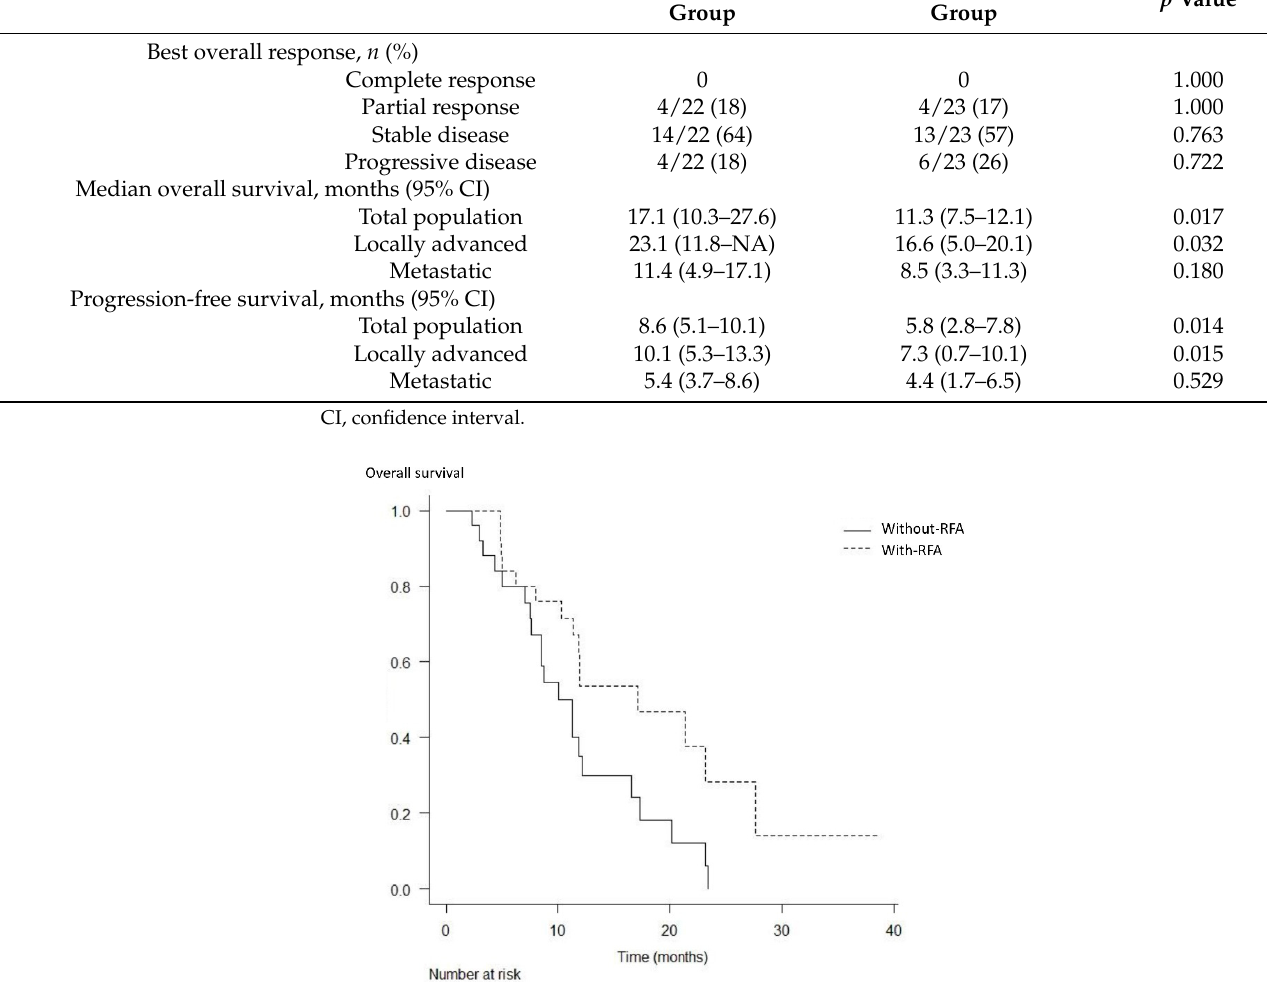
With-RFA Without-RFA p Value Group Group